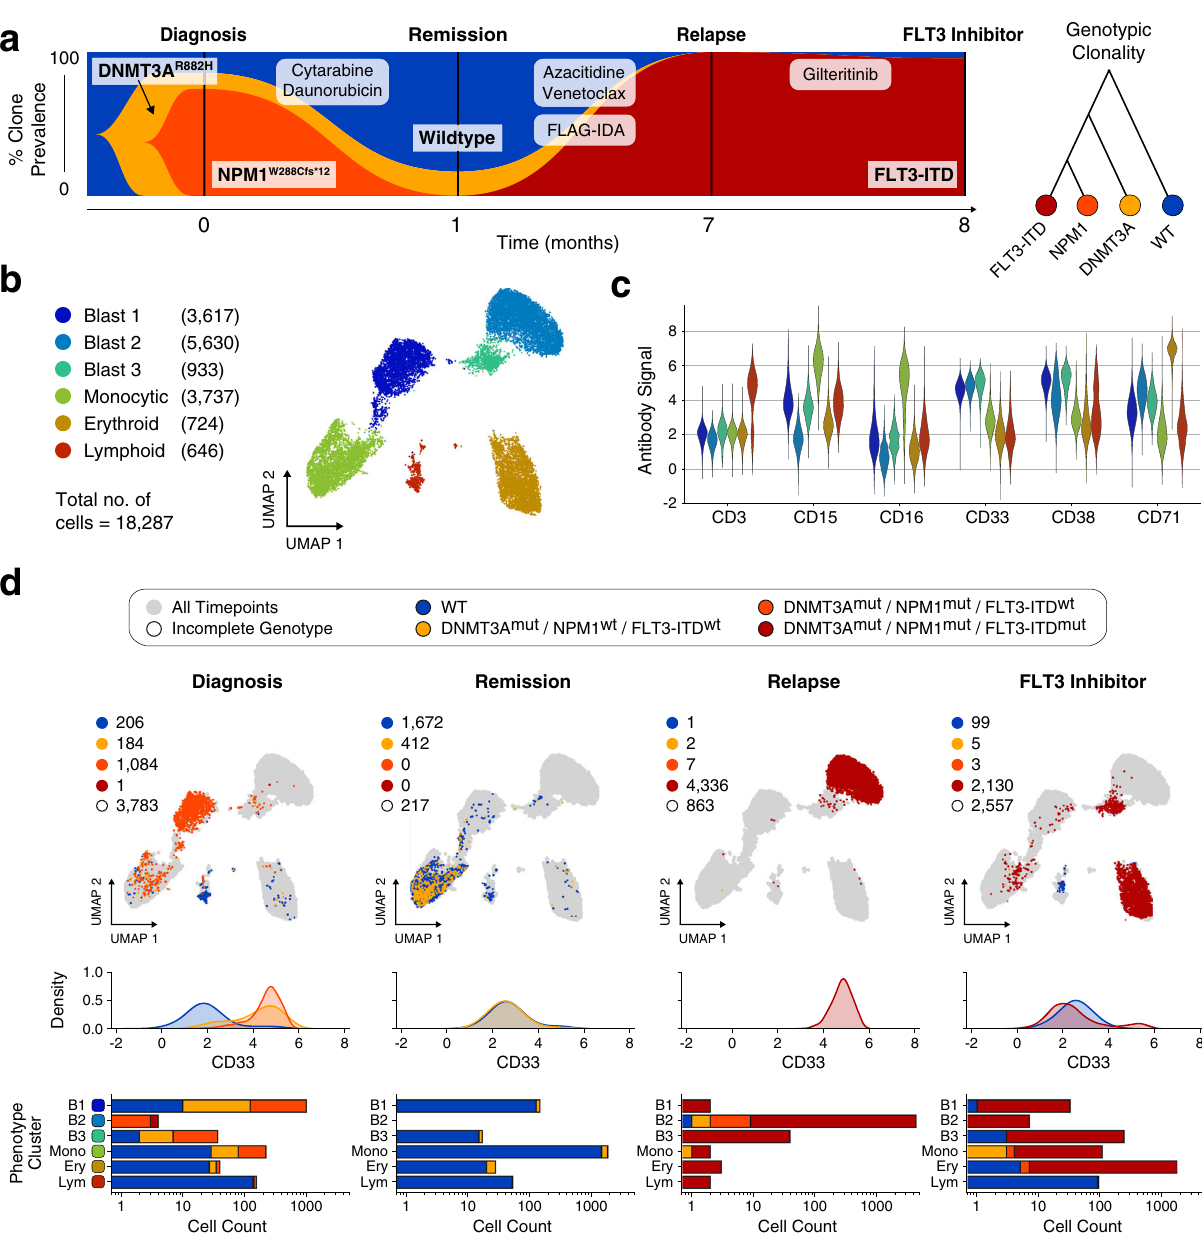
Fig. 5 Decoupling of blast phenotype and genotype in response to FLT3 inhibitor therapy. a Fishplot showing observed fraction of cells with distinct genetic mutations for each sampled timepoint. The co-occurrence of the three mutations in the single-cell data is consistent with a linear model of mutation accumulation. b UMAP embedding of all cells based on measured antibody signal. The cells segregate into six distinct phenotypic clusters with multiple blast compartments. c Average expression of each cell cluster for a selection of markers. d Top row: Same UMAP embedding as in b given as grey outline. For each sampled timepoint, observed cells are plotted and colored according to the detected genotype. Blasts distribute among multiple phenotypic compartments in the fi nal timepoint following FLT3 inhibitor treatment. Middle row: kernel density plot of the CD33 antibody signal resolved by timepoint and genotype. Cells from genotypic compartments with less than ten cells per timepoint are not plotted. Bottom row: bar chart depicting genotypic composition of each phenotypic cluster in b resolved by timepoint. Source data are provided as a Source data fi le. Methods A detailed step-by-step protocol for DAb-seq has been submitted to the protocols. io repository 40 . The cost analysis for a DAb-seq experiment is provided in Sup- plementary Table 7. Conjugation of antibodies to oligonucleotide barcodes . Monoclonal antibodies were conjugated to azide-modi fi ed oligonucleotides using a copper-free click cleotide barcode sequences. Antibodies were incubated with DBCO-PEG5-NHS